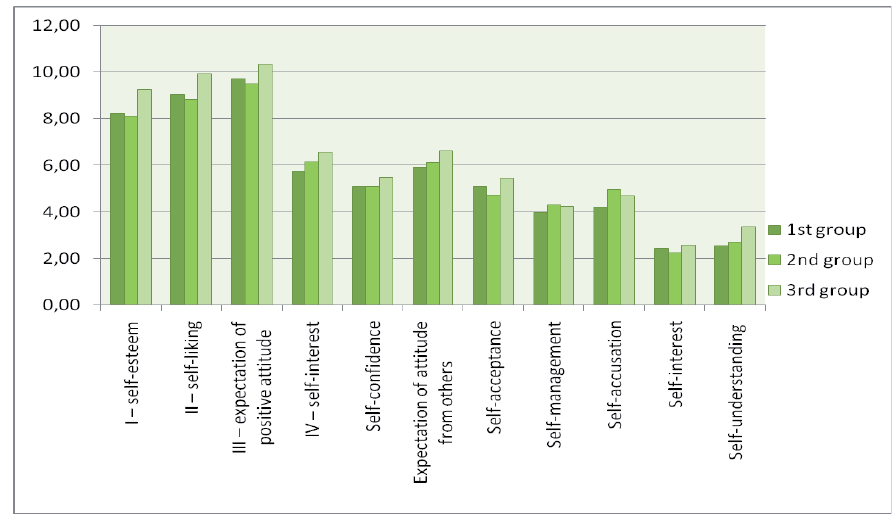
Fig. 1. Comparison of self-regard indicators in three groups under research